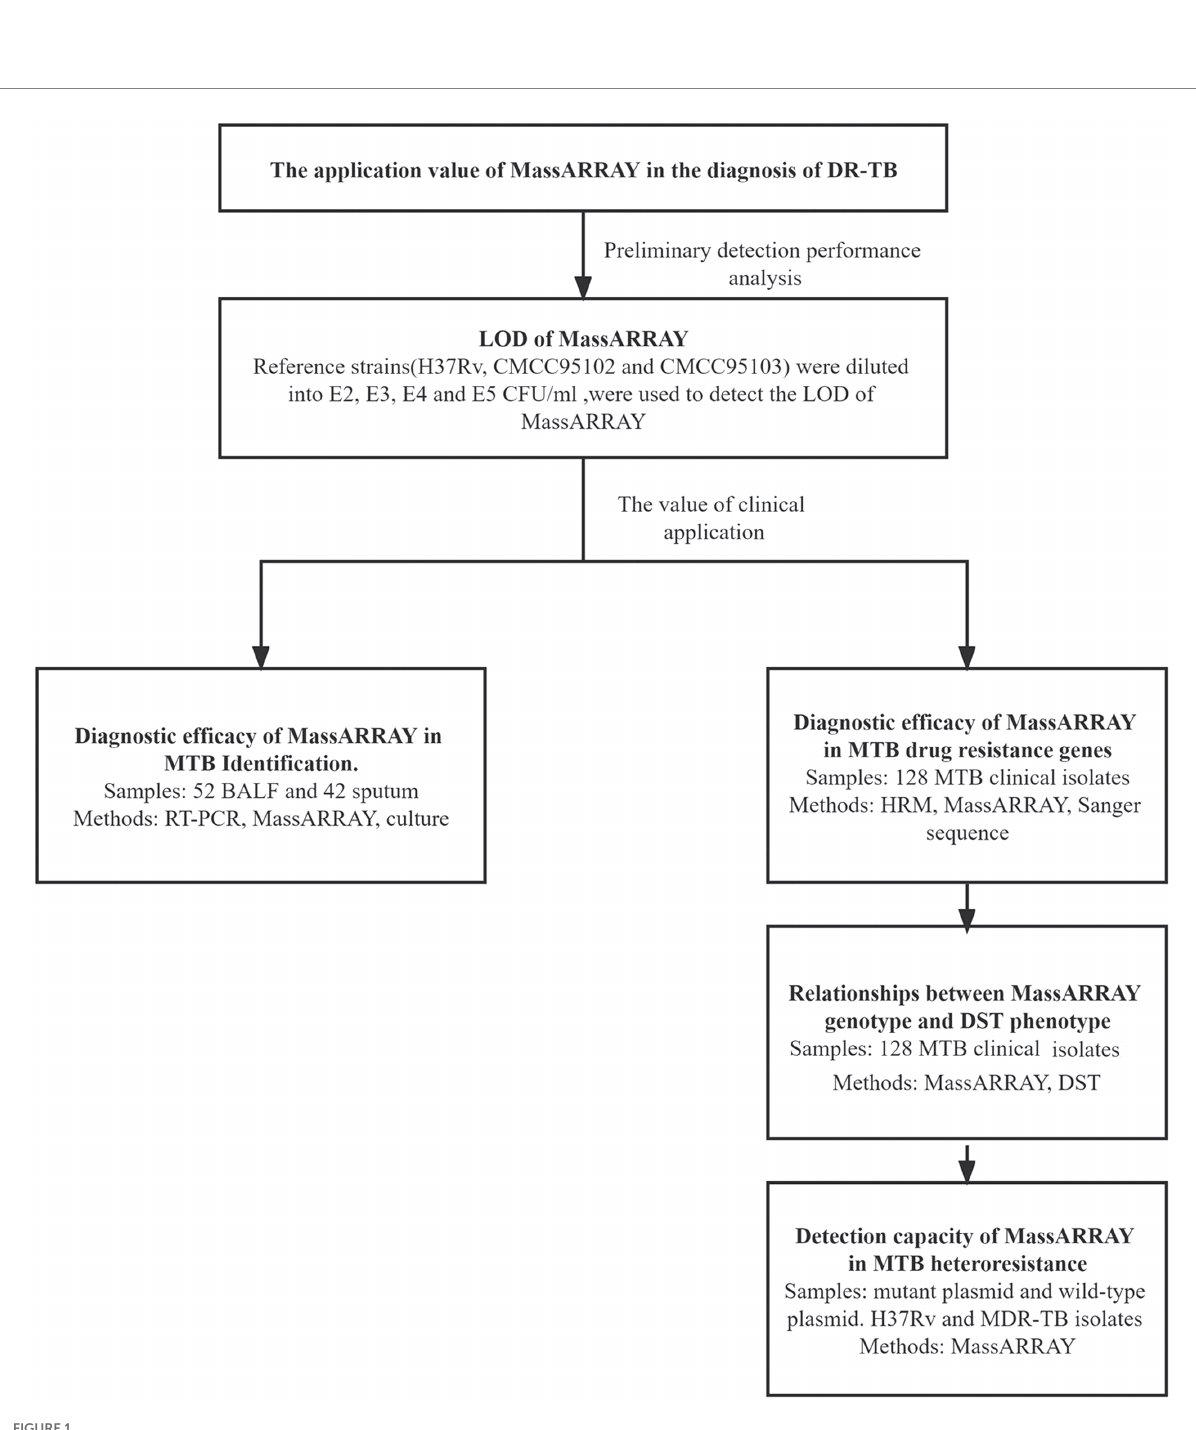
FIGURE 1 Design of